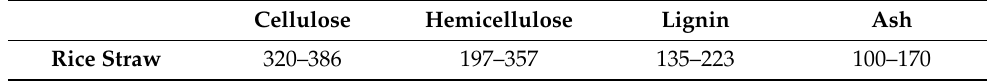
Table 4. Major components of rice straw (mg/g) (modified from [73]).